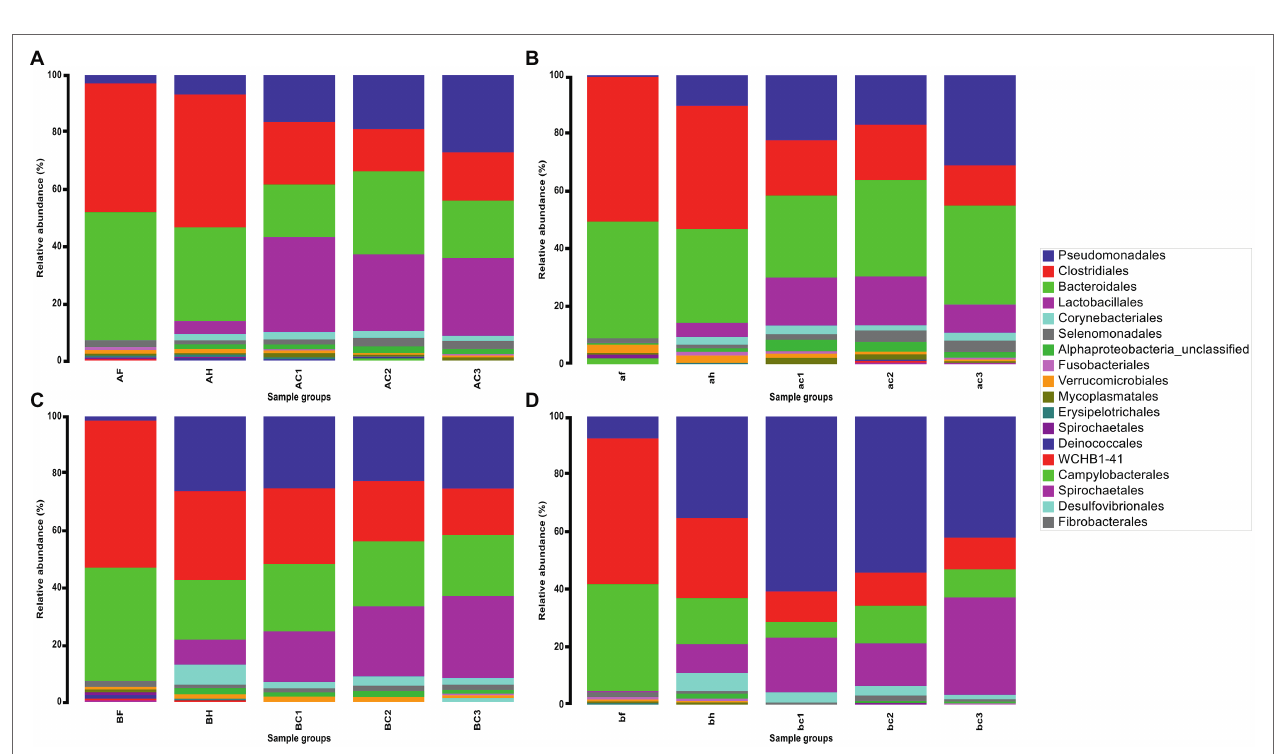
FIGURE 3 | Relative abundance (%) of 18 OTUs at the Order taxonomy in fecal, hide, and carcase groups. (A) First visit to abattoir A; (B) second visit to abattoir A; (C) first visit to abattoir B; and (D) second visit to abattoir B. The groups are labeled in upper and lower cases for the first and second visits to the abattoir, respectively. There are three sample groups; fecal (F or f), hide (H or h), and carcase (C or c) groups. C1, C2, and C3 represent post-hide pull, post-evisceration, and pre-chill carcases,